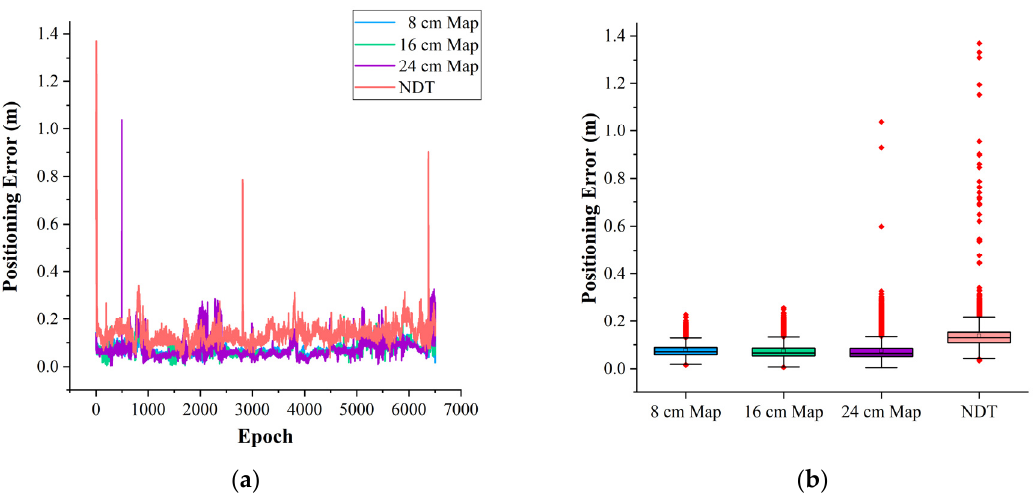
Figure 9. Time series and boxplots of positioning errors in road environments. ( a ) is time series of positioning errors and ( b ) is boxplots of positioning errors. Table 4. The RMS of attitude error using different map resolution in different scenes. Table 3. The RMS of position error using different resolution maps in different scenes.